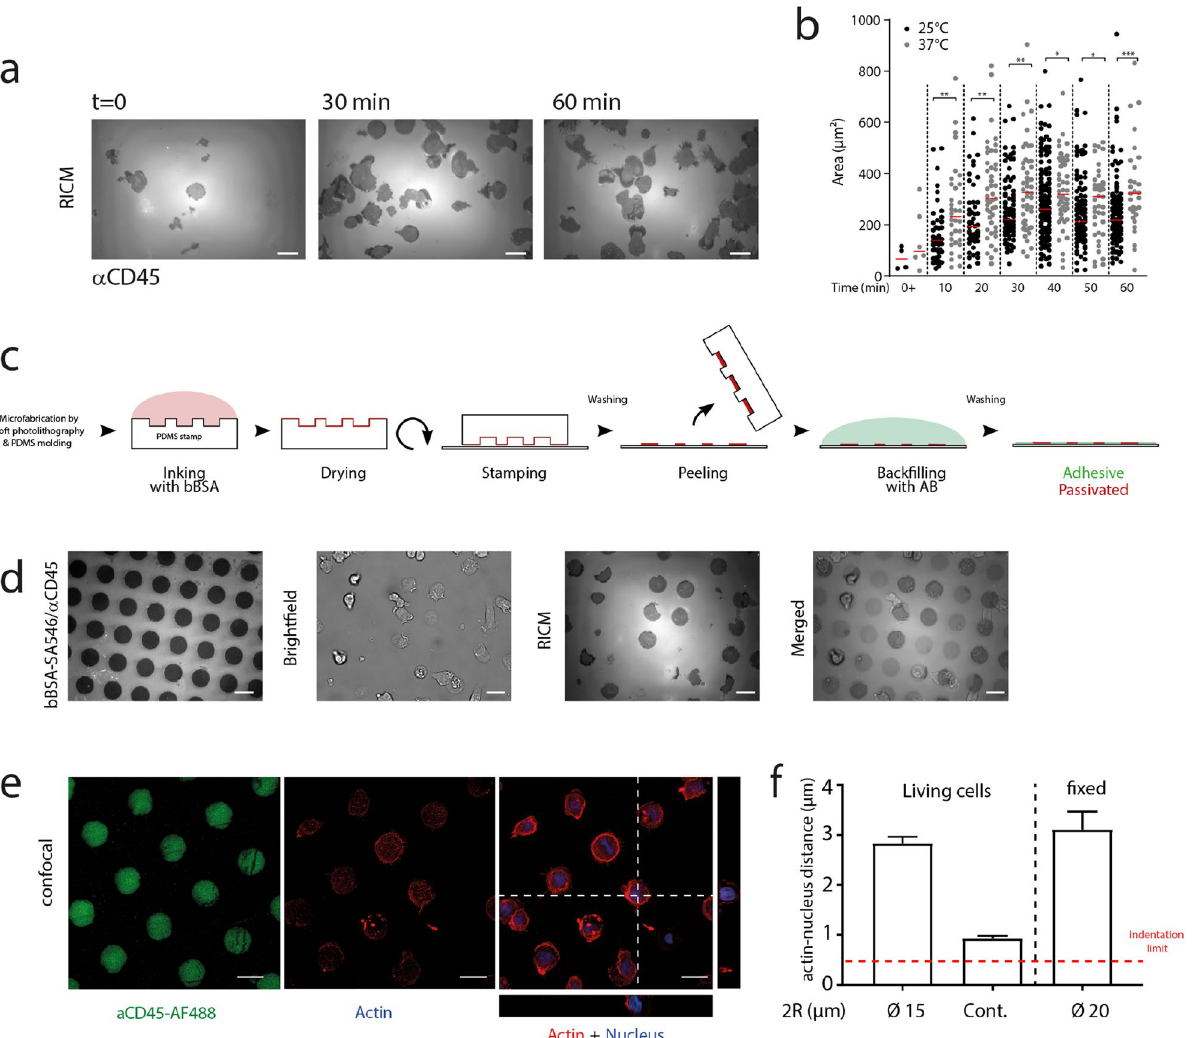
Figure 2. ( a ) RICM images of adhesion and spreading of 3A9m cells on anti CD45 “continuous” (here denominated as “cont.”) substrate at given time points. ( b ) Adhesion area on anti CD45 antibodies of cells vs. time at 25 °C and 37 °C. Each point represents a cell, and the bar denotes the median value. Statistical differences between temperatures at each time point were assessed using Mann–Whitney test. The adhesion after 60 min at 37 °C corresponds to an equivalent disk of diameter of ~ 20 µm. ( c ) Schematics of the inverse microstamping method, where the repulsive molecule (BSA or bBSA) is stamped first, before adsorbing the adhesive one (anti CD45) in the free zones. ( d ) Images of obtained substrates: (i) fluorescence image of the repulsive zones, completed with non labeled anti CD45 antibodies in the patterns (dark), (ii) brightfield images of 3A9m cells after 60 min incubation, (iii) corresponding RICM image of the adhesion zones, (iv) overlay of the three previous pictures. ( e ) Confocal imaging of 3A9m cells showing patterns of anti CD45 antibodies (green) cortical actin (red) and nucleus (blue), with projections of the z-stack. ( f ) Estimation of the distance between the cortical actin and the nucleus (mean+/SEM), to determine the maximal indentation for the Hertz-like fit (dotted line, see text). Scale bar = 20